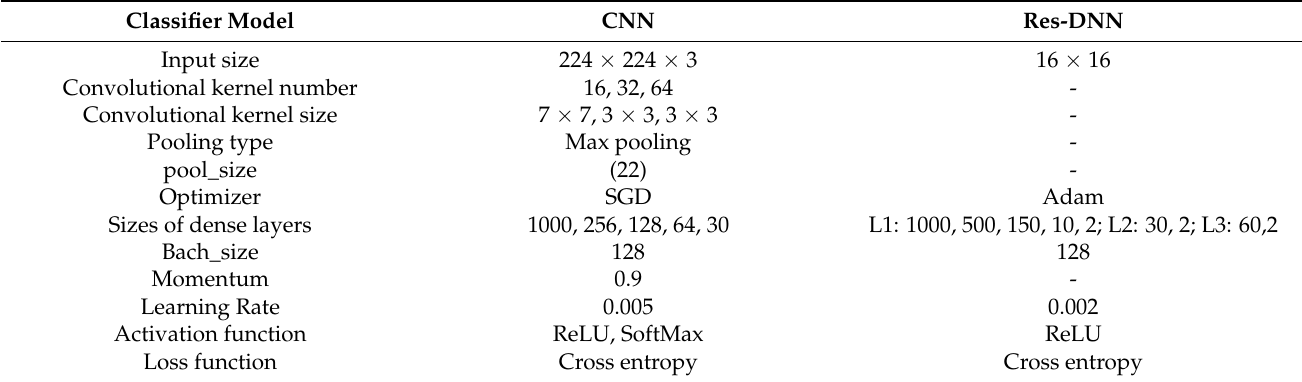
Table 2. Parameters configuration of the CNN and Res-DNN.